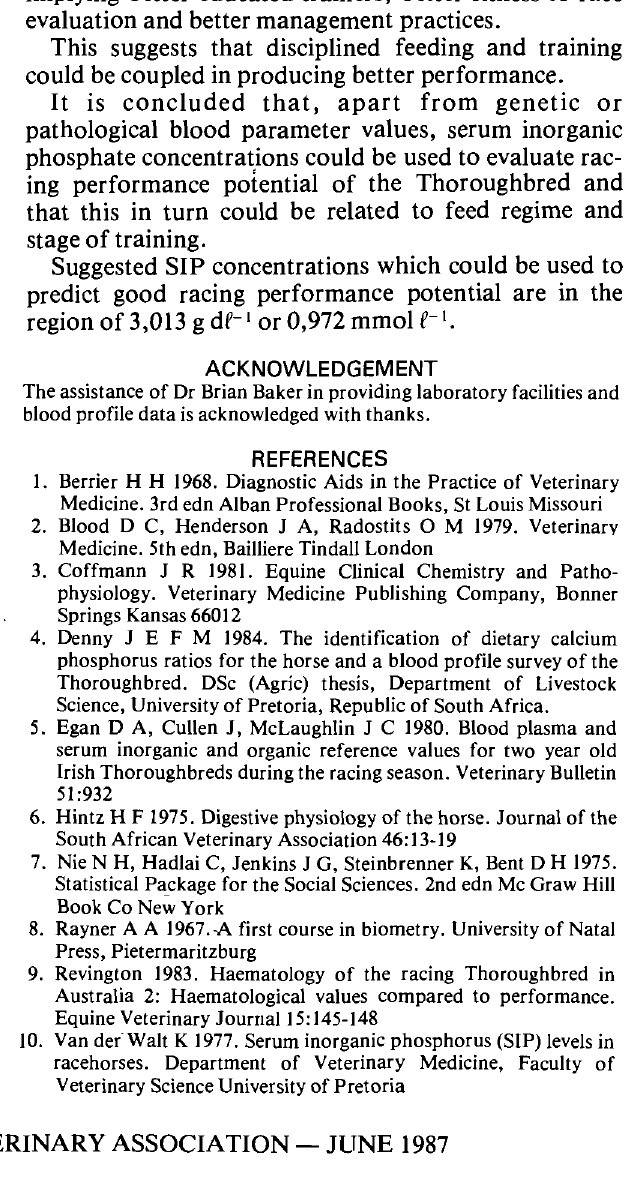
Fig. 2: Observed and expected race placings of horses on Feed 1 and Feed 4from-X 2 contingency